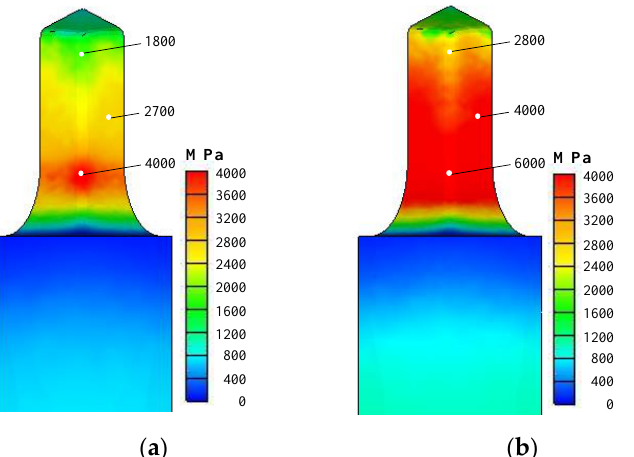
Figure 7. Dies stresses obtained by isothermal and non-isothermal FE analyses [8]: ( a ) Non-isothermal; ( b ) Isothermal.